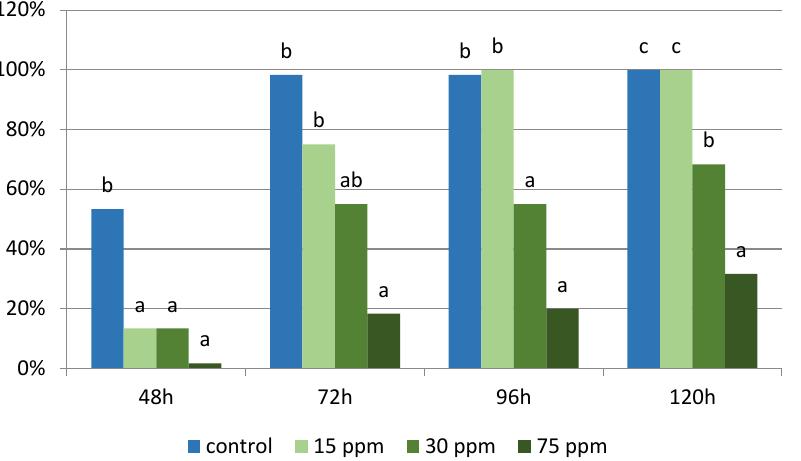
Figure 4. Rate of infections of tomato seed culture after application of different concentrations of silver nanoparticles (75 ppm, 30 ppm and 15 ppm). The control sample was treated with sterile water. Treatments were compared using analysis of variance and Fisher’s LSD test for each term separately. Parameters in columns denoted with the same letters (a. b. c.) do not differ statistically at the confidence level of p < 0.05.